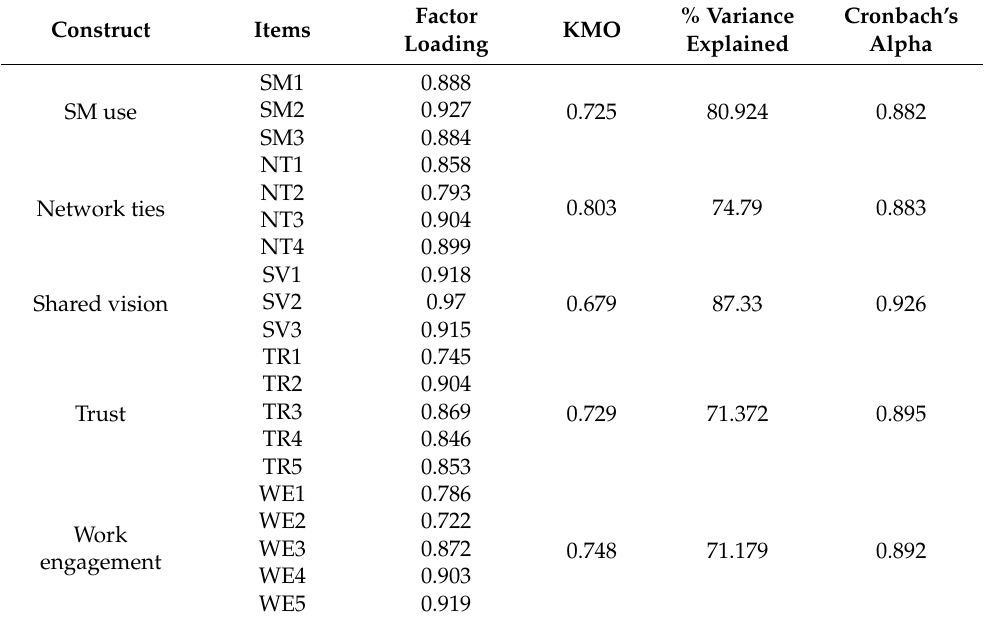
Table A2. Summary of the pilot test